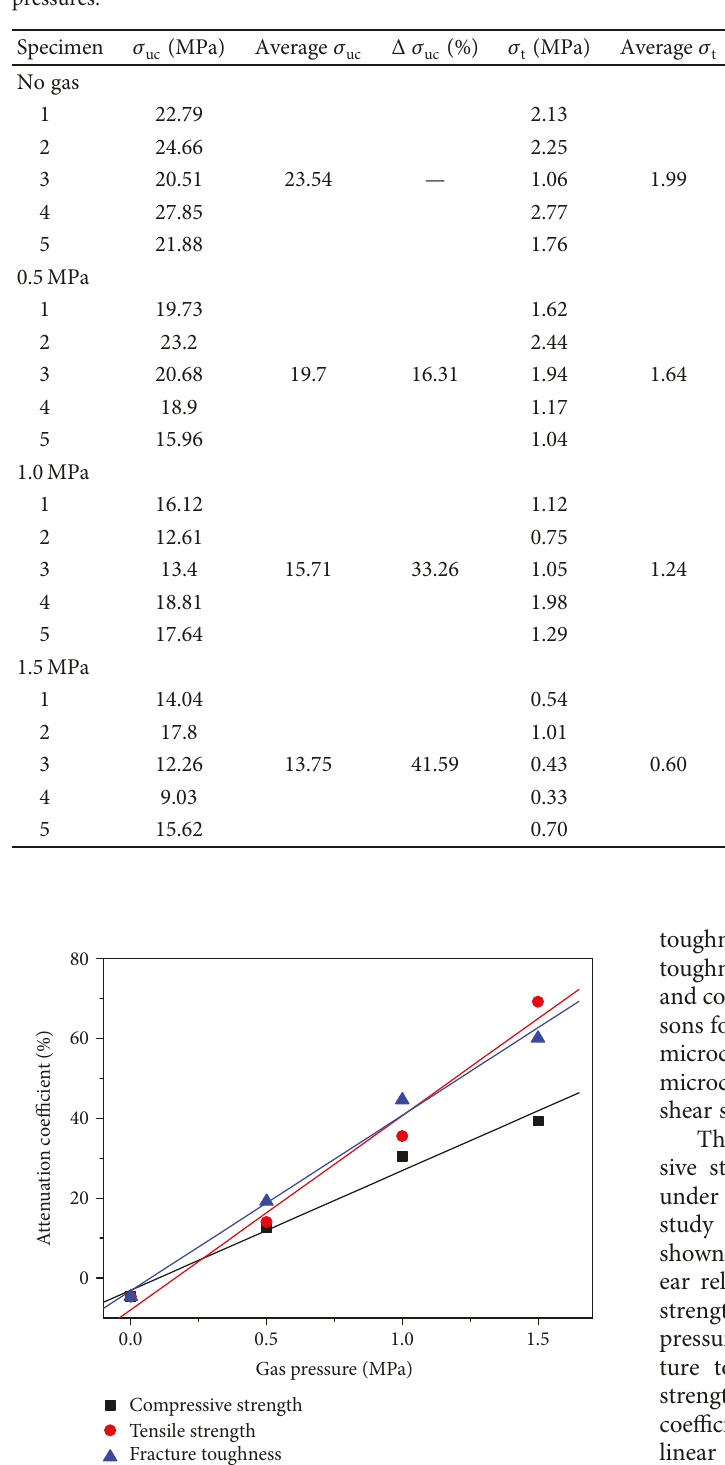
K IC ) of coal under di